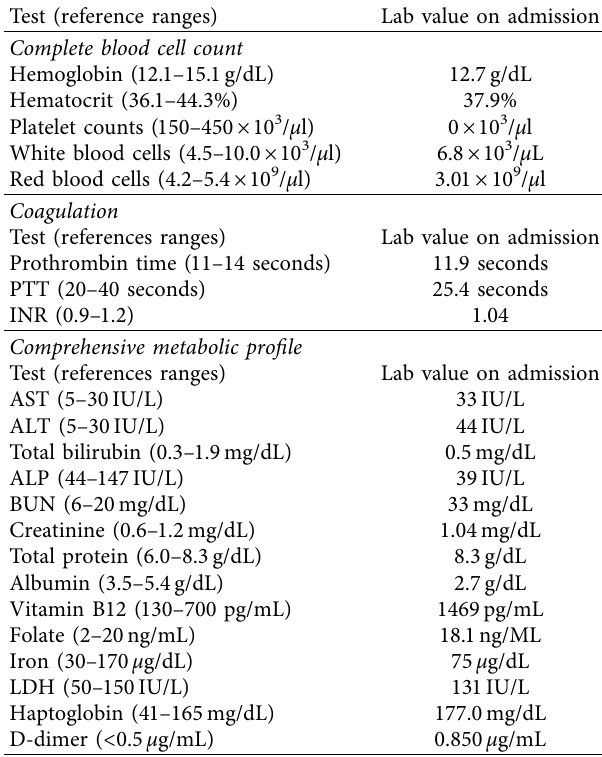
Table 1: Laboratory values on